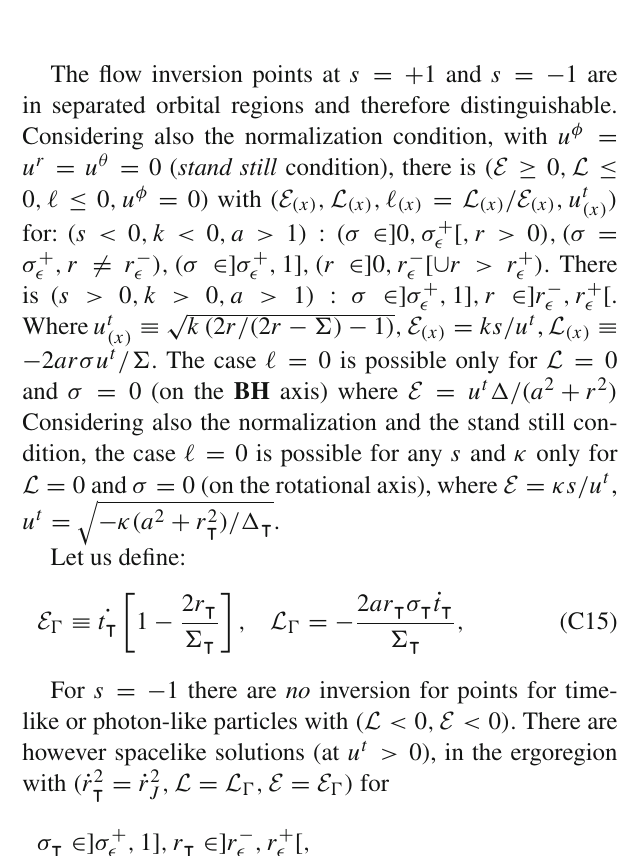
< r − < r + < r + as functions of δ δ 0 0